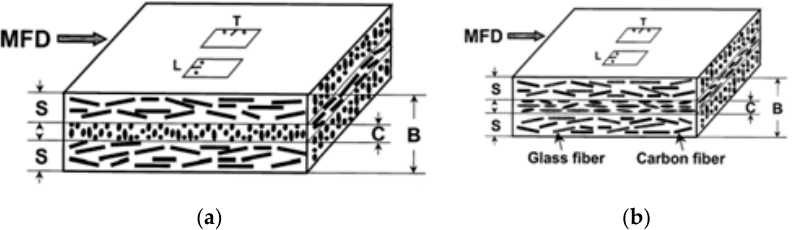
Figure 5. Schematic illustration showing the three-layer structures for ( a ) single-additive and ( b ) hybrid composites with GFs/CFs